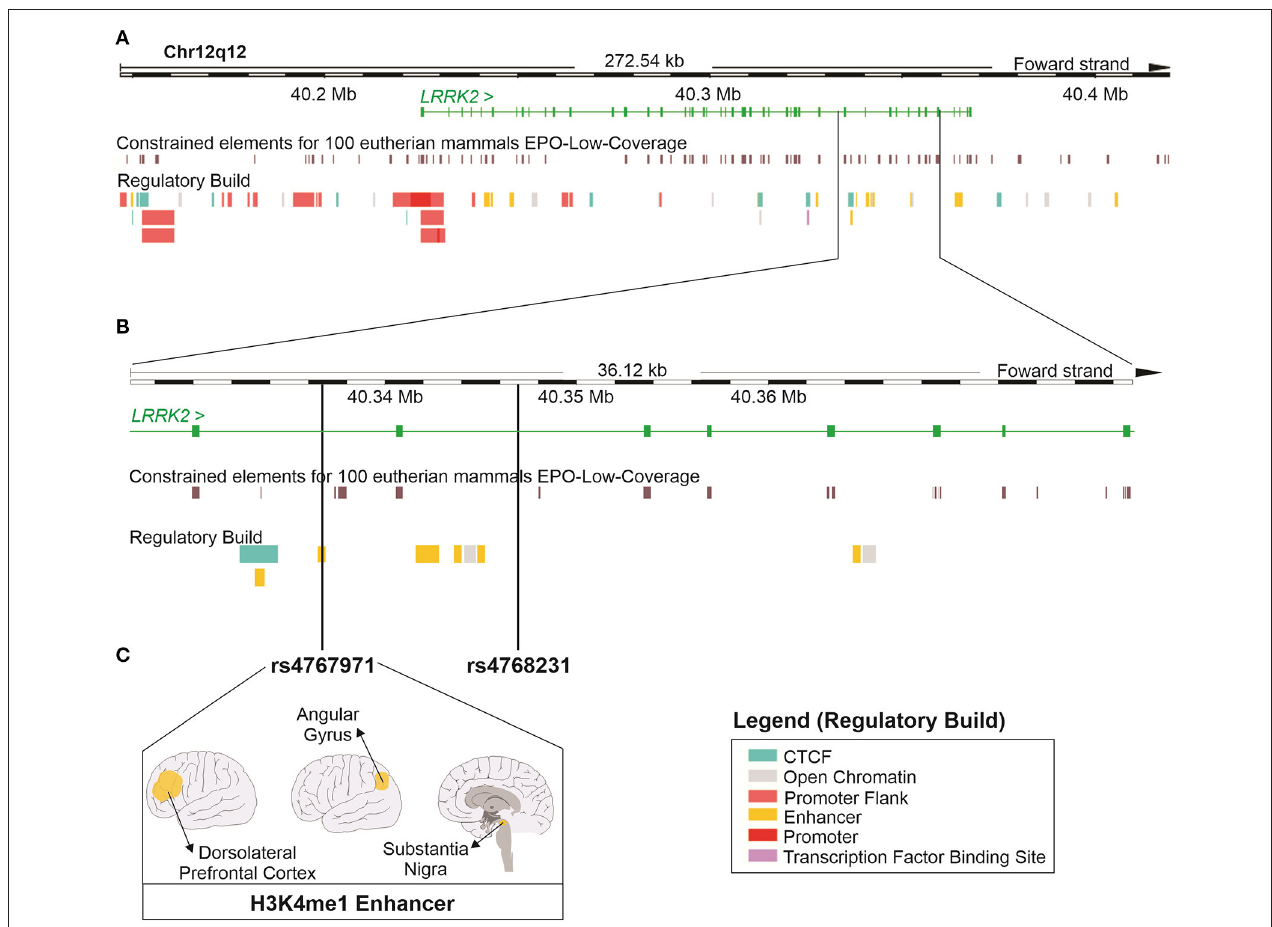
FIGURE 2 | In silico functional study on the properties of the LRRK2 variants associated with alcohol dependence in the three cohorts. (A) Schematic representation of the locus containing the LRRK2 gene (12:40,146,744–40,419,285; RefSeq: GRCh38). The green continuous lines and rectangles represent introns and exons of the LRRK2 gene, respectively. This region was cross-referenced with DNA sequence annotations, including the location of constrained elements for 100 eutherian mammals and the position of regulatory elements (Regulatory Build). (B) Magnified view of a region within the LRRK2 gene where single-nucleotide polymorphisms (SNPs) rs4767971 and rs4768231 can be found. (C) rs4767971 is located within an H3K4me1 enhancer element identified in tissues from the brain dorsolateral prefrontal cortex, angular gyrus, and substantia nigra. Image created using the Ensembl Genome Browser (http://www.ensembl.org). H3K4me1: mono-methylation at the fourth lysine residue of the histone H3